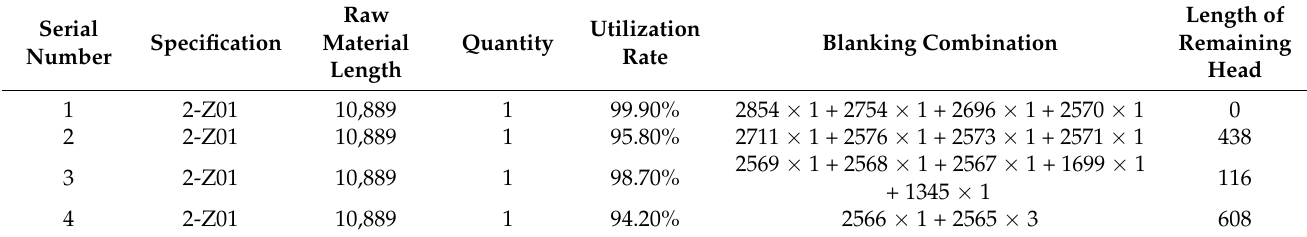
Table 3. 2-Z01 keel blanking combination.